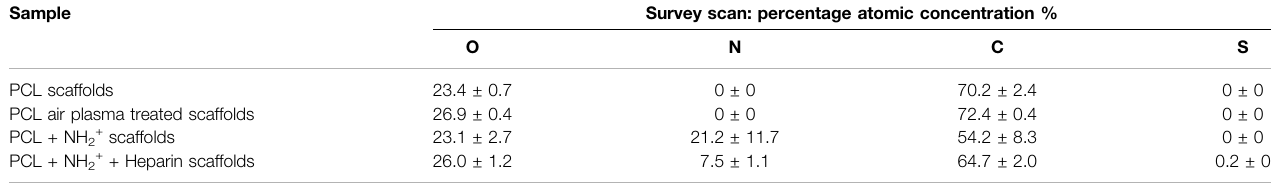
TABLE 1 | Percentage of atomic concentration of PCL scaffolds, PCL Air scaffolds, PCL NH 2+ scaffolds and PCL NH 2+ + Heparin scaffolds obtained from XPS analysis survey scans. Si content was also detected on the surface. Sample